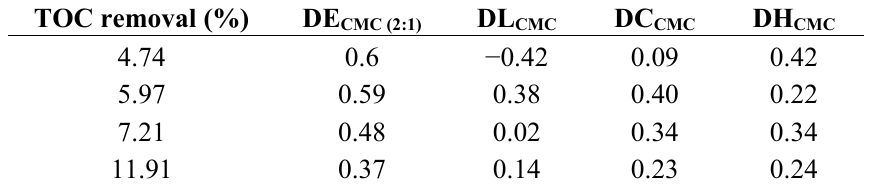
Table 4. Influence of the TOC removal in the PN dyeing result. Color differences of fabrics dyed with the treated and reused effluent vs. the